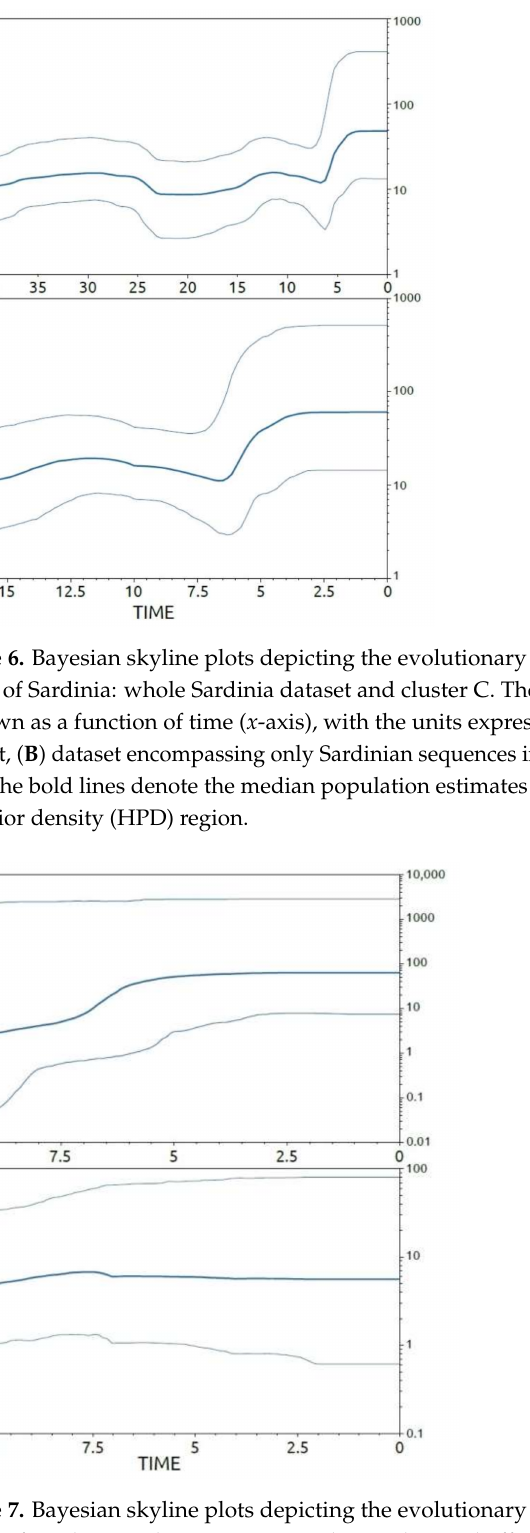
Figure 7. Bayesian skyline plots depicting the evolutionary history of ASFV on the Mediterranean island of Sardinia: sub-groupss C2 and C1. The viral effective population size ( y -axis) is shown as a function of time ( x -axis), with the units expressed in years. ( A ) Dataset encompassing only Sardinian sequences included in sub-group C2 of the phylogenetic tree; ( B ) dataset encompassing only Sardinian sequences included in sub-group C1 of the phylogenetic tree. The bold lines denote the median population estimates and the grey lines denote the 95% high posterior density (HPD)